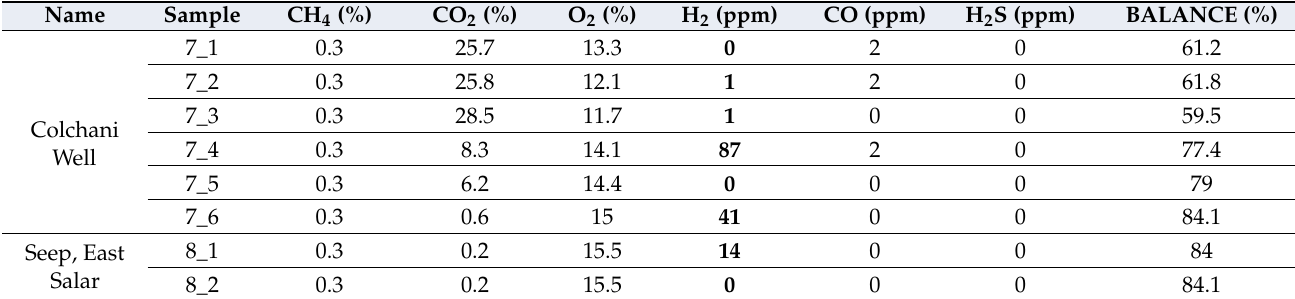
Table 1. Soil gas in situ measurement around the Uyuni